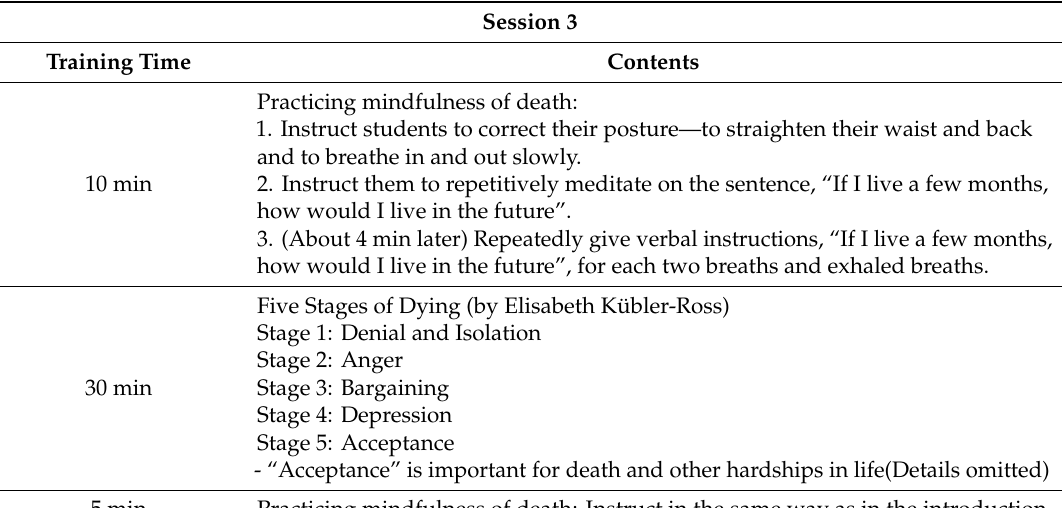
Table 1. Example of Mindfulness of Death Based Death Education